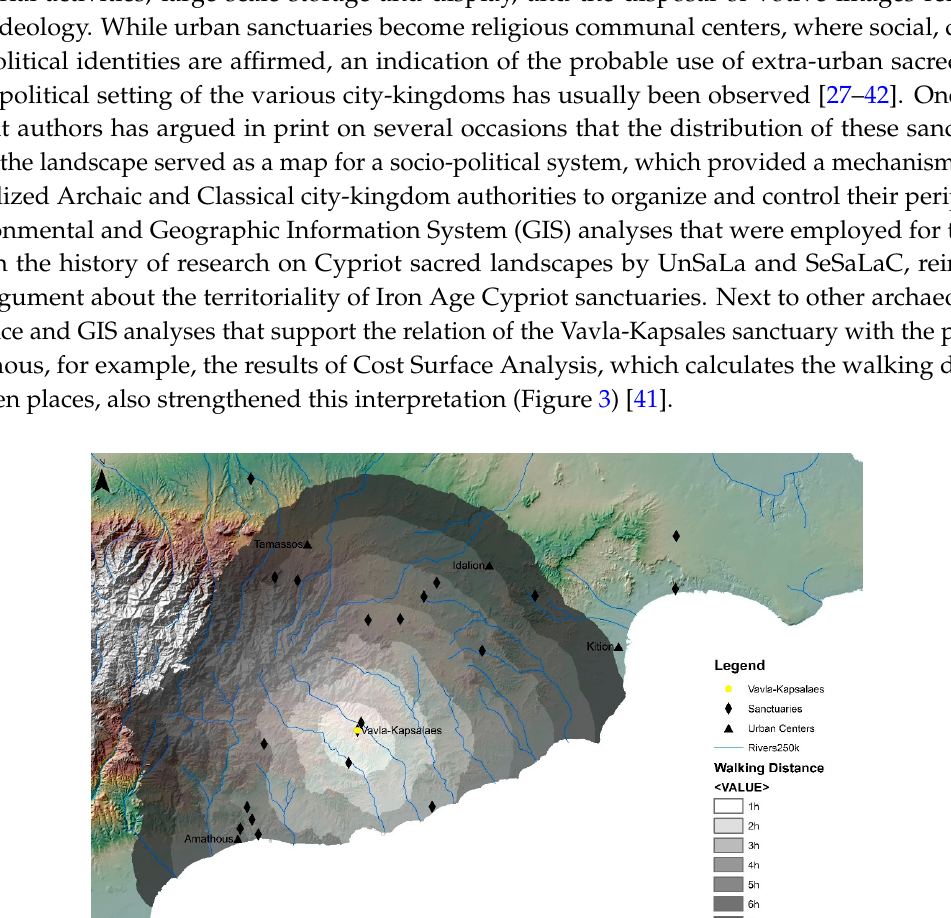
Figure 3. Cost Surface Analysis results from the Vavla-Kapsales ancient sanctuary (digital geological data courtesy of the Geological Survey Department, Republic of Cyprus; GIS analysis by N. Kyriakou).